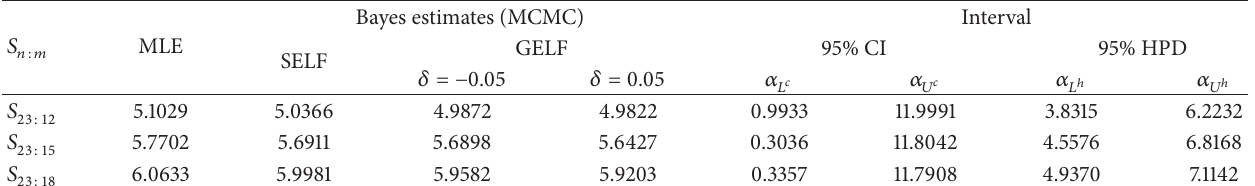
Table 8: Bayes and ML estimates, CI and HPD intervals for 𝛼 with fixed 𝑛 = 23 and 𝑝 = 0.5 under PT-II CBR.